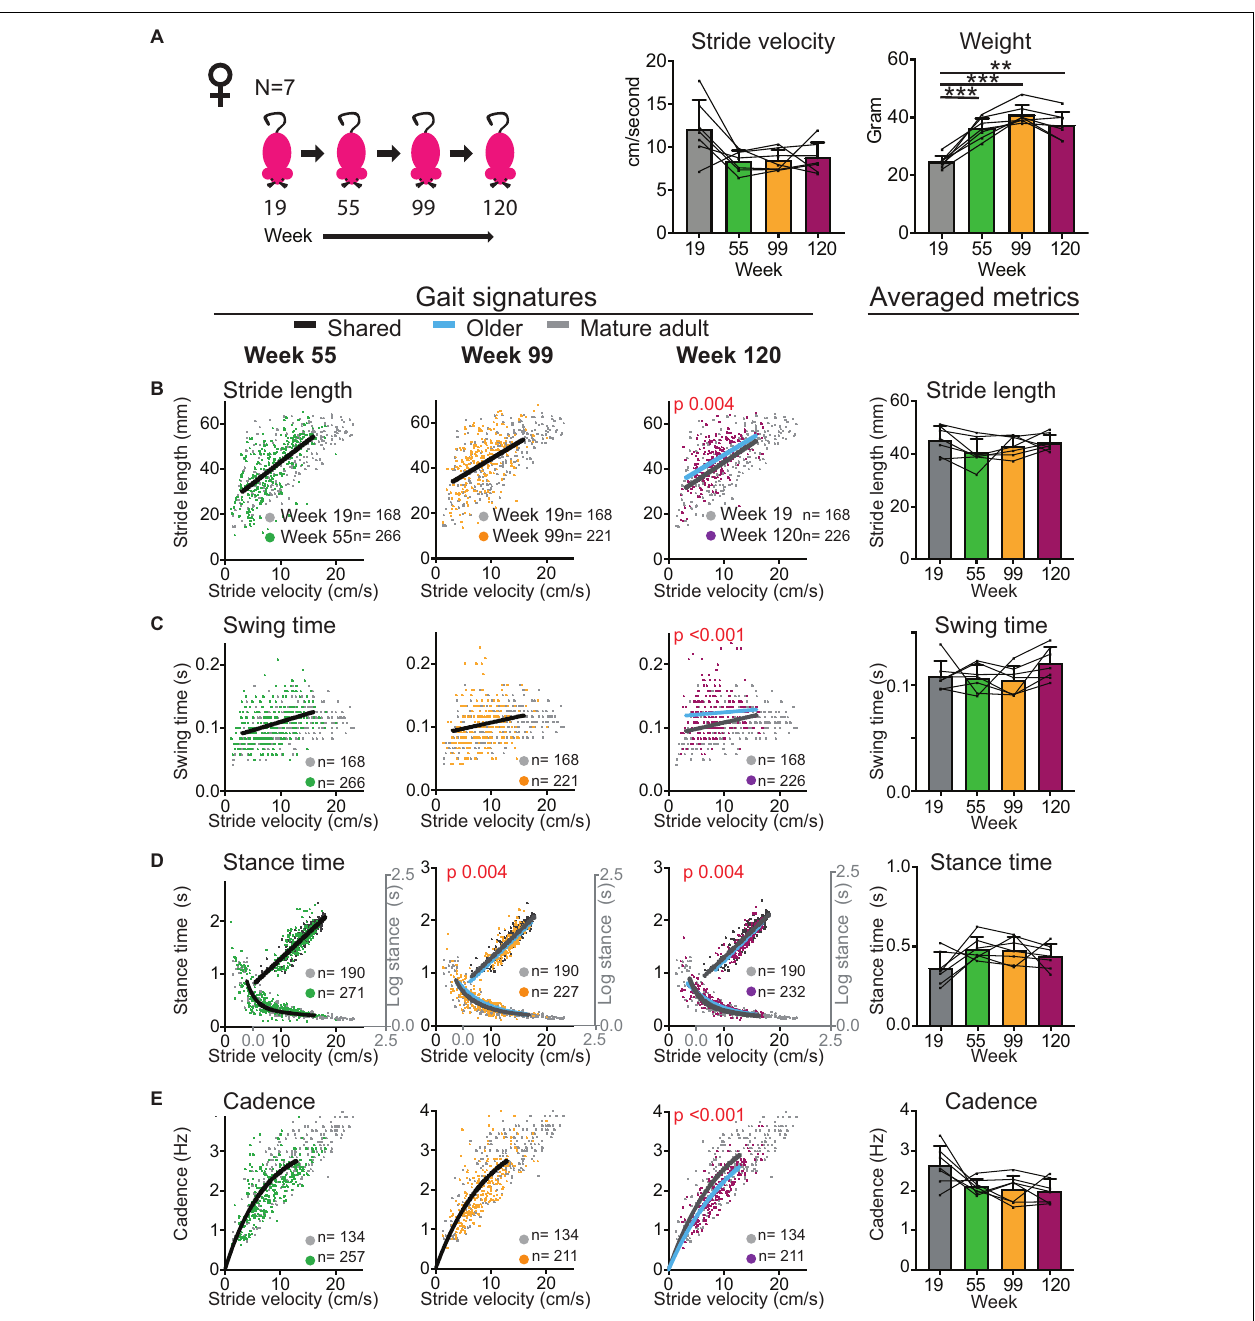
FIGURE 3 | Gait signatures in female mice shift at the geriatric time point without an accompanying decline in walking speed. (A) Bar graphs of weight and average stride velocity from continuous walking bouts on a walkway at key time points in the sub-cohort of female mice that reached the 120 week end point. Error bars indicate standard deviation. RM-one-way ANOVA followed by Dunnett’s multiple comparison test with correction for multiple comparisons; family alpha 0.05. (B–E) Stride by stride gait metrics stride length (B) , swing time (C) , stance time (D) , and cadence (E) plotted as a function of stride by stride velocity. Gray dots represent data from week 19 (mature adult) whereas green, orange and purple represent data from weeks 55, 99, and 120, respectively. Single curves or lines indicate that the dataset from week 19 and older time points fit the same curve, whereas separate lines indicate that datasets cannot be fitted in the same model and are significantly different (Sum of square F -test; alpha 0.001). Note the shift in curves or gait signatures (blue lines) in the geriatric age group (week 120). Bar graphs to the right show averaged metrics to illustrate variation between animals and time points. Error bars indicate standard deviation. Curves were fitted for the velocity range that represents walking gait. N , number of mice; n , number of strides included in the analyses. RM-one-way ANOVA followed by Dunnett’s multiple comparison test with correction for multiple comparisons; family alpha 0.05. Statistical analyses are summarized in Supplementary Table 2 . ** and *** represent p values of < 0.01 and < 0.001,